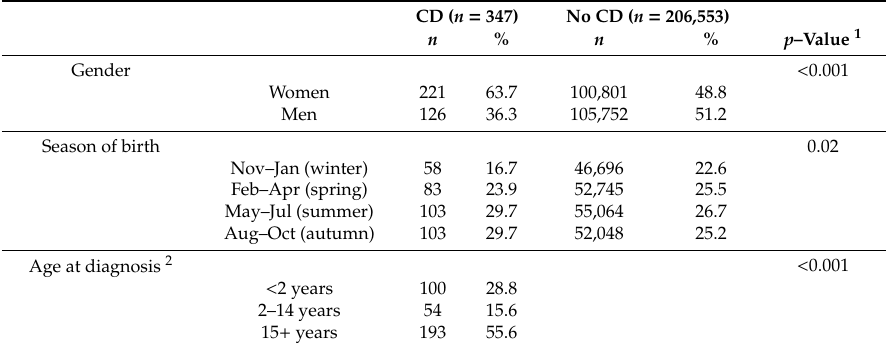
Table 1. Characteristics of population with coeliac disease (CD) compared to those without ( N = 206,900).